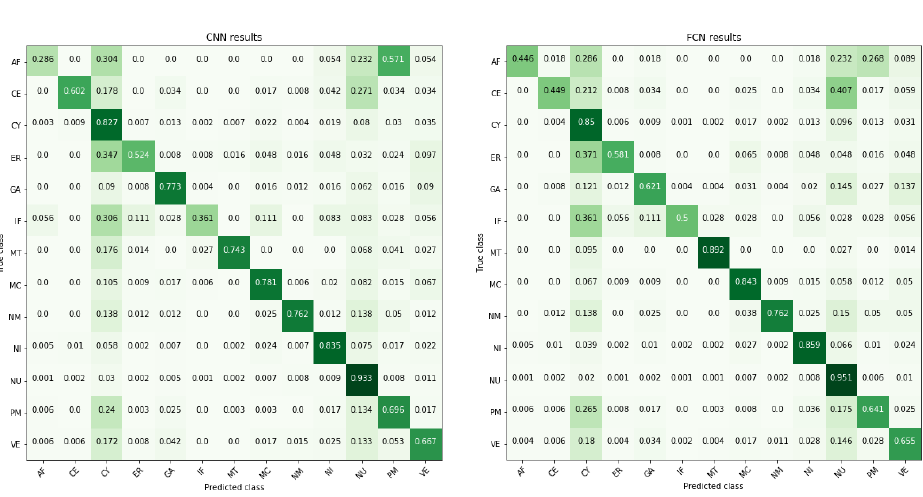
Figure 4. Prediction results as confusion matrices reveal which classes are often mixed with others. In case of multiple labels in sample, each true label not found gets a hit from all predicted false positives. The diagonal shows percentage of correctly classified samples. Mean of diagonal (unweighted class average) is 0.676 for CNN and 0.696 for FCN. Darkness (value) of color represents percentage; higher percentages are depicted with darker